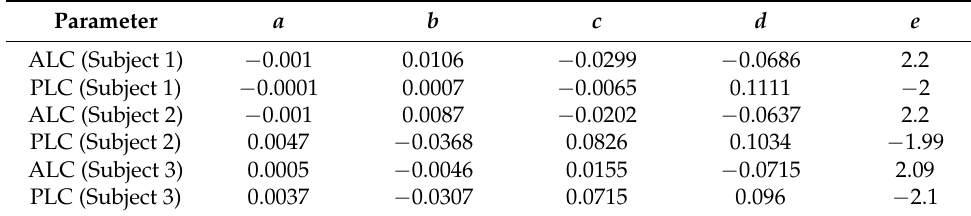
Table 1. Polynomial parameters of lens surface profile.